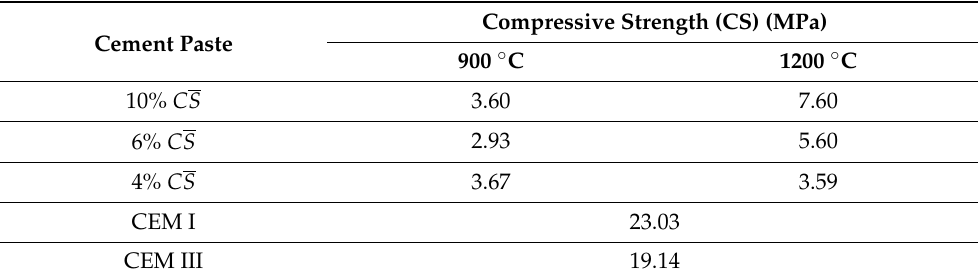
Table 6. Compressive strength at 7 days of curing of the cement pastes produced by indirect